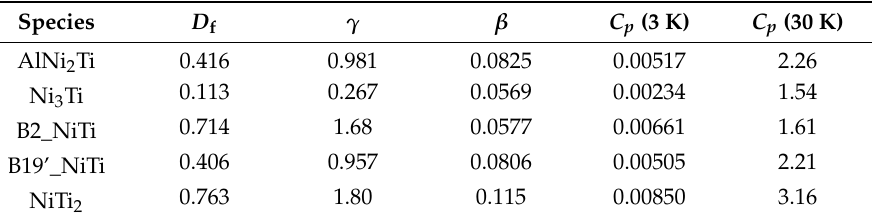
Table 5. Theoretically calculated low-temperature specific heat of AlNi 2 Ti and Ni-Ti binary compounds, including the total density of states at the Fermi level ( D f , states/(eV · atom)), the characteristic parameters of electron ( γ , mJ/(K 2 · mol)) and phonon ( β , mJ/(K 4 · mol)) specific heat, and the specific heat ( C p , J/(K · mol)) at 3 K and 30 K for comparison. Species D f γ β